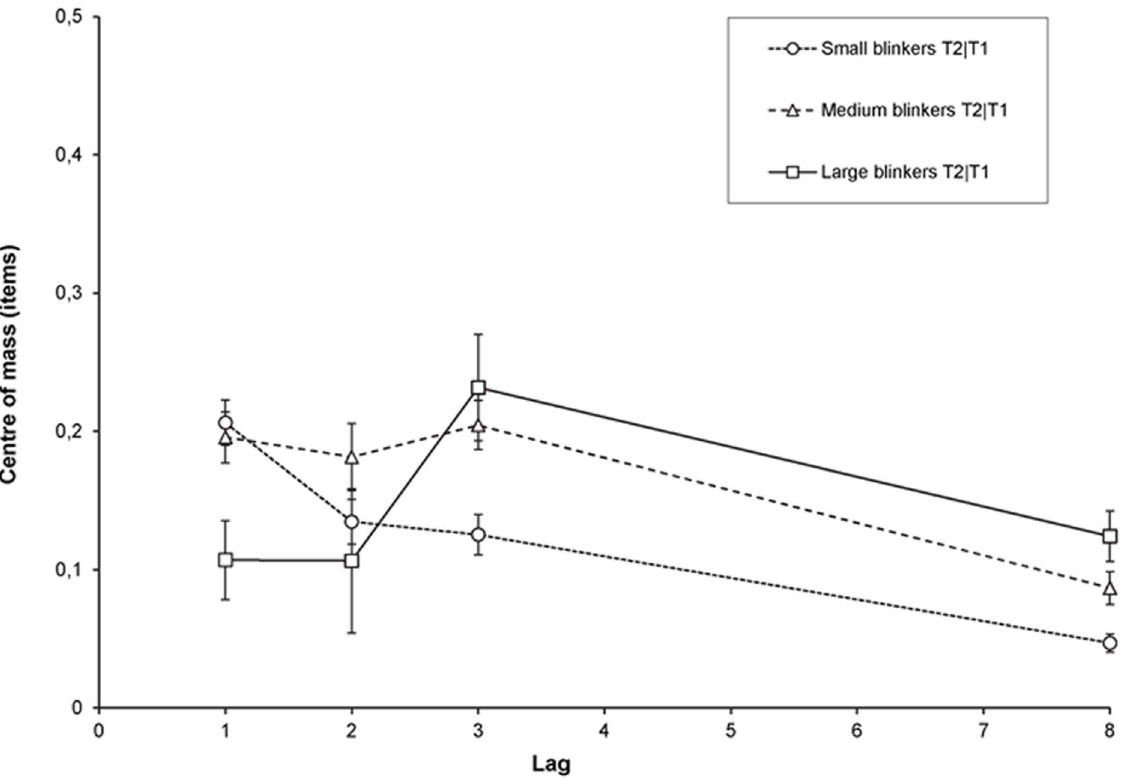
Figure 11. Delay in Experiment 2. Delay of the temporal selection process expressed as the centre of mass of reports in the selection window around a given target as a function of lag, for small, medium, and large blinkers.